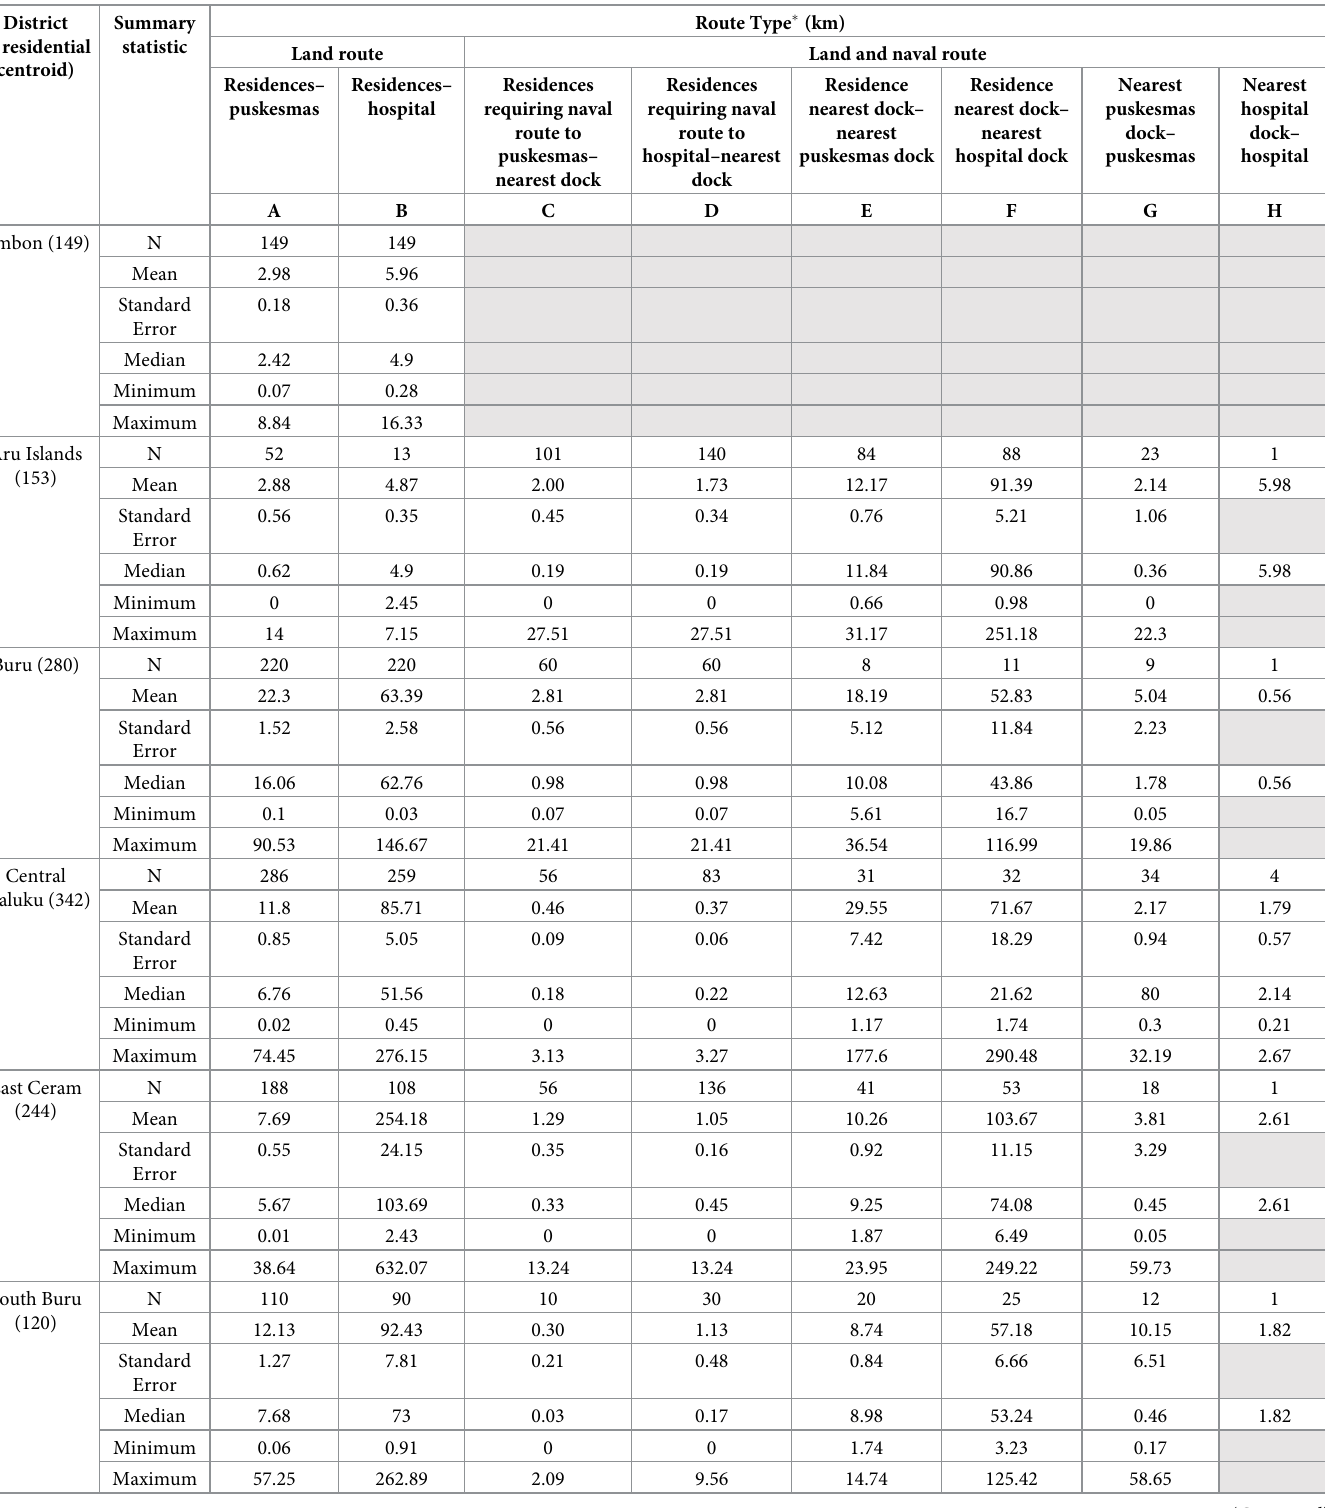
Table 2. Descriptive statistics summarizing route characteristics by type (A-H, Fig 2) and district. District (#